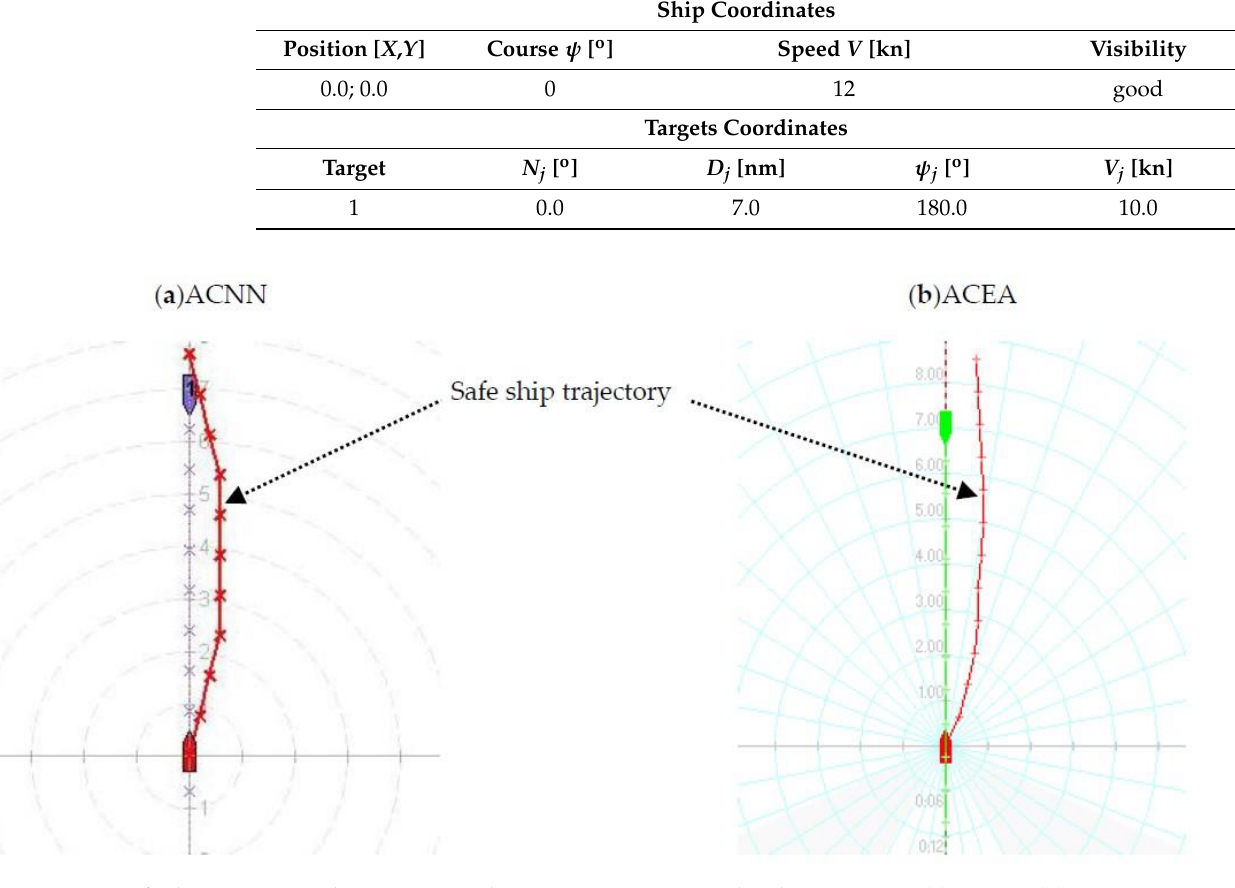
Figure 6. Safe ship trajectory when passing with one moving target in a head-on situation. ( a ) ACNN, ( b ) ACEA. Table 2. Data on the trajectories of the ship — ACNN algorithm.